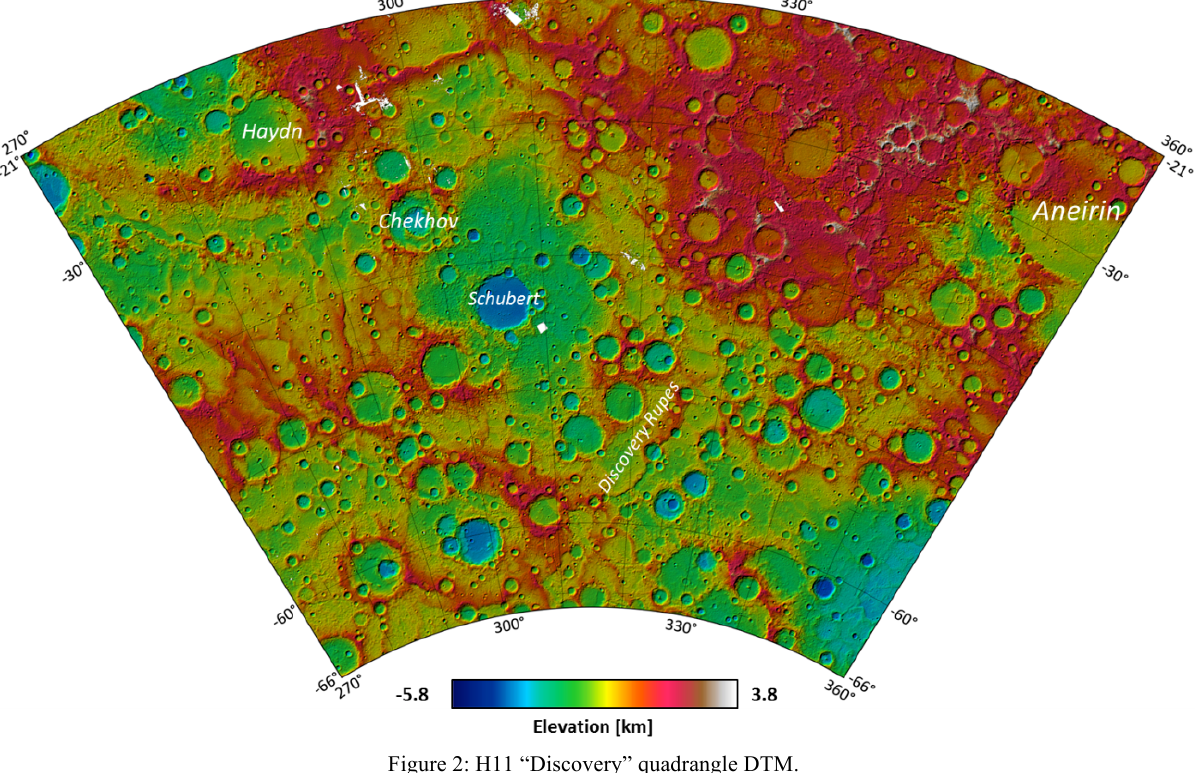
Figure 2: H11 “Discovery” quadrangle DTM.